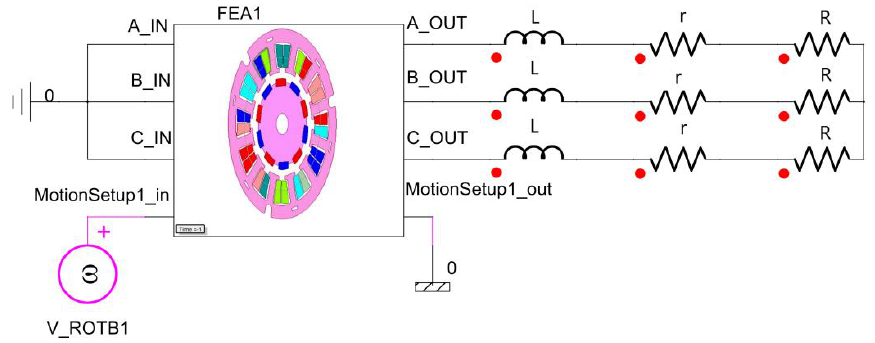
Figure 5. Electrical-magnetic simulation model.